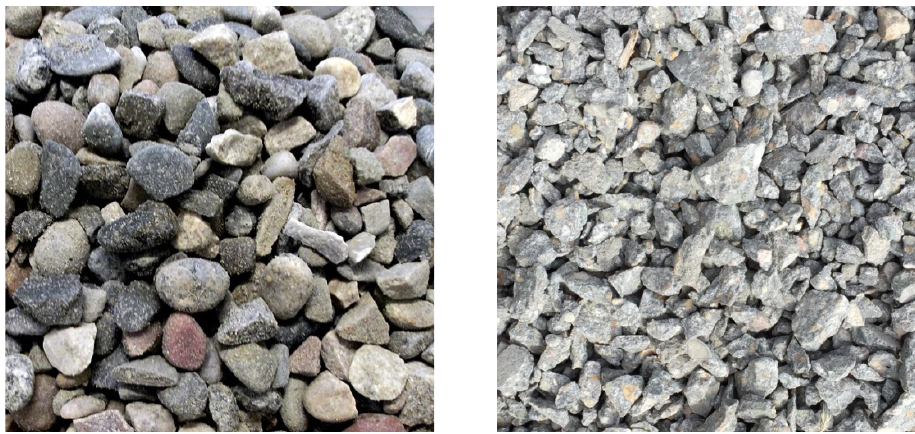
Figure 10. The visual comparison of particles of the natural ( left ) and recycled ( right ) coarse aggre- gates.